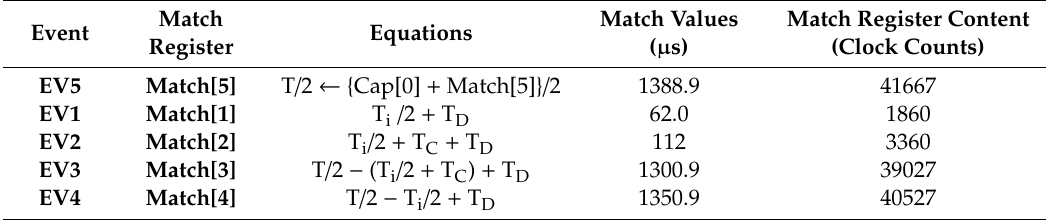
Table 1. Match values related to EV1-EV5 events calculated as a function of measurement parameters T i , T D , and T C , and the measured T value (see text).